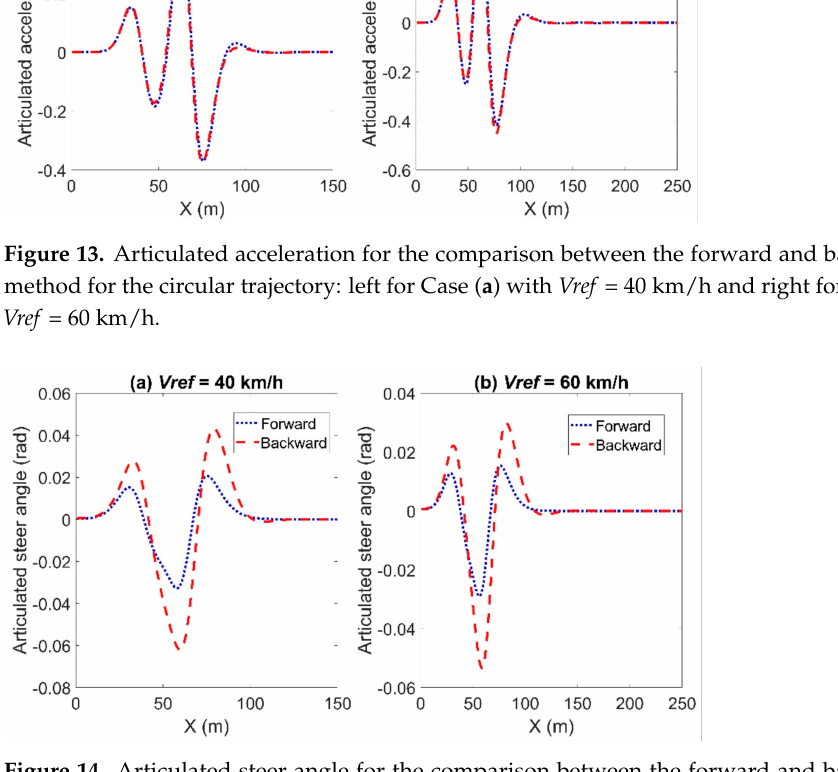
Figure 14. Articulated steer angle for the comparison between the forward and backward Euler method for the circular trajectory: left for Case ( a ) with Vref = 40 km/h and right for Case ( b ) with Vref = 60 km/h.